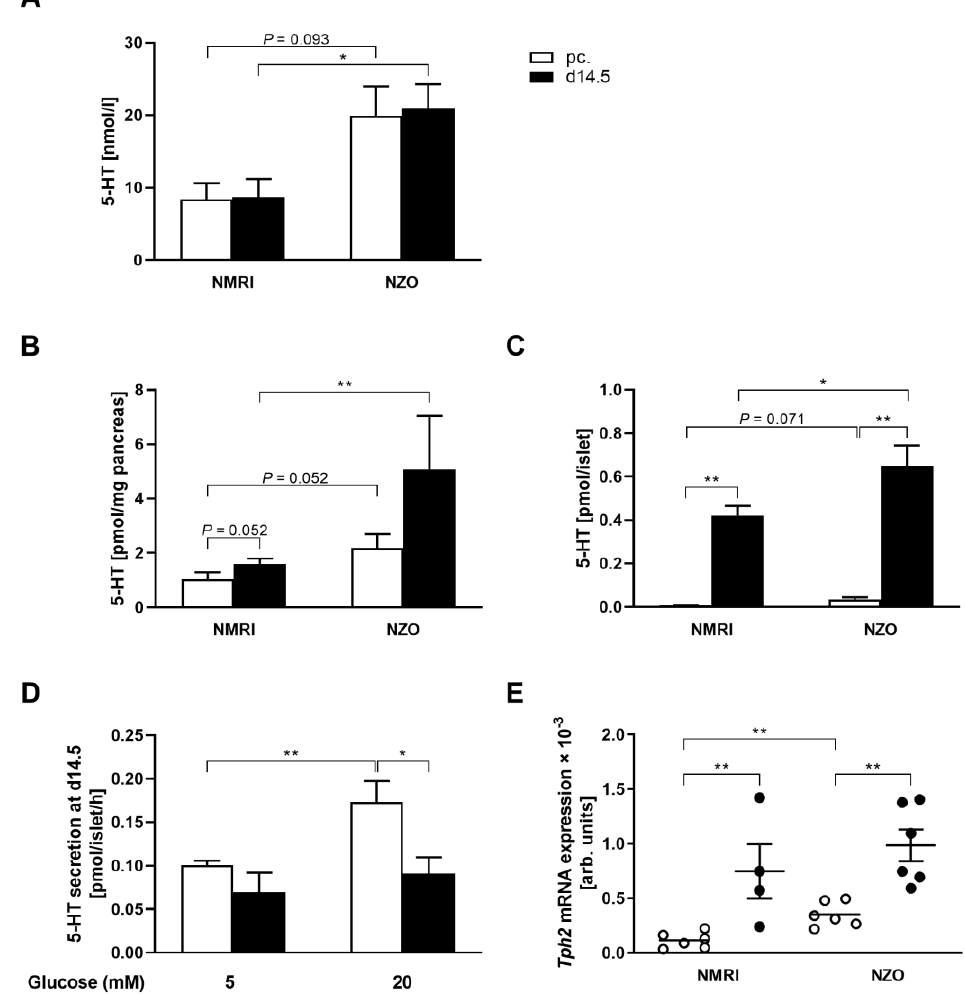
Figure 1. Elevated 5-HT plasma levels and increased 5-HT concentrations but impaired 5-HT secretion in islets of Langerhans of female NZO mice. ( A ) Random plasma 5-HT concentrations of NMRI and NZO mice at time points preconceptional (white bars) and d14.5 of gestation (black bars). ( B ) Total pancreatic 5-HT content and ( C ) islet 5-HT content were determined in acidic extracts preconceptionally (white bars) and at d14.5 of gestation (black bars) of NMRI and NZO mice. ( D ) 5-HT secretion after static incubation with 5 and 20 mM glucose at d14.5 of NMRI (white bars) and NZO mice (black bars). ( E ) Tph2 gene expression in islets of NMRI and NZO mice at time points preconceptional (white circles) and d14.5 (black circles). Data are presented as means ± SEM ( A n = 6, B n = 4–6, C n = 4–6, D n = 6, and E n = 4–6 animals per group). * p < 0.05; ** p < 0.01.